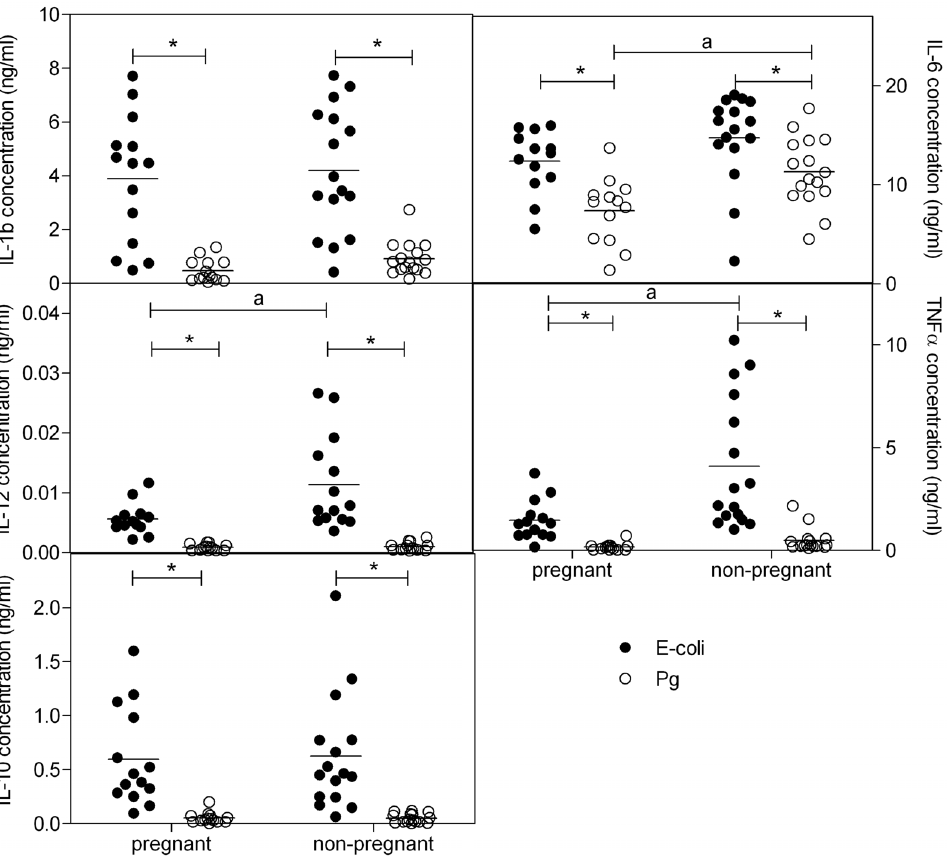
Figure 3. Cytokine concentrations following stimulation with LPS. Concentrations (ng/ml) of IL-1b, IL-6, IL-12, TFN a and IL-10 in plasma of pregnant and non-pregnant women following stimulation of whole blood with E-coli (black dots) or P. Gingivalis (PG) (open dots) LPS (2 m g/ml) for 24 hr. *significantly different from E-coli (two-way ANOVA followed by Bonferroni post-tests, p , 0.05). a: significantly different from pregnant women after the same stimulation (two-way ANOVA followed by Bonferroni post-tests, p , 0.05).